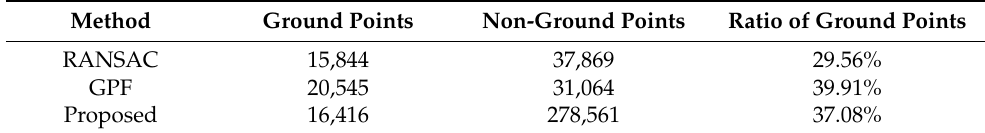
Table 2. Statistics of ground points and non-ground points in Figure 9.